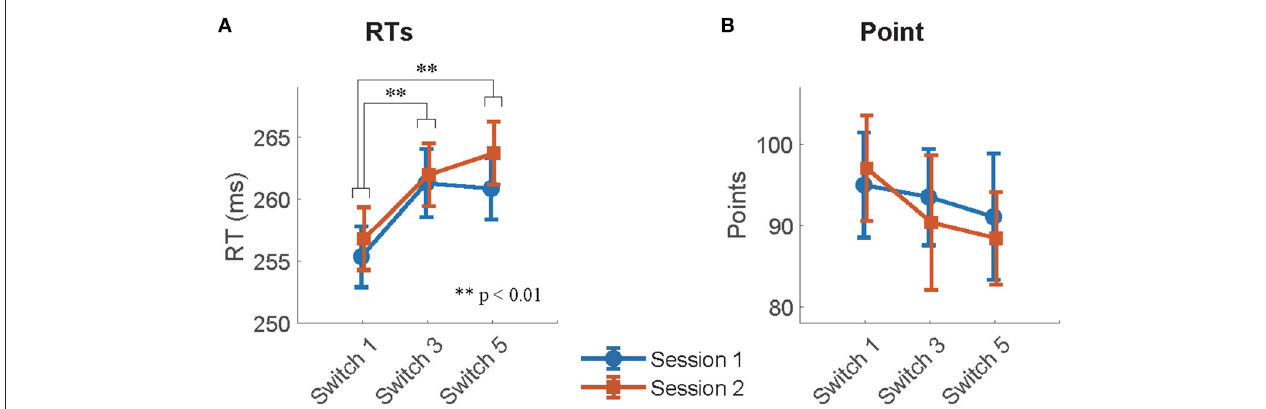
TABLE 2 | Estimated coefficients of fixed effects in LMEs for RTs and points.